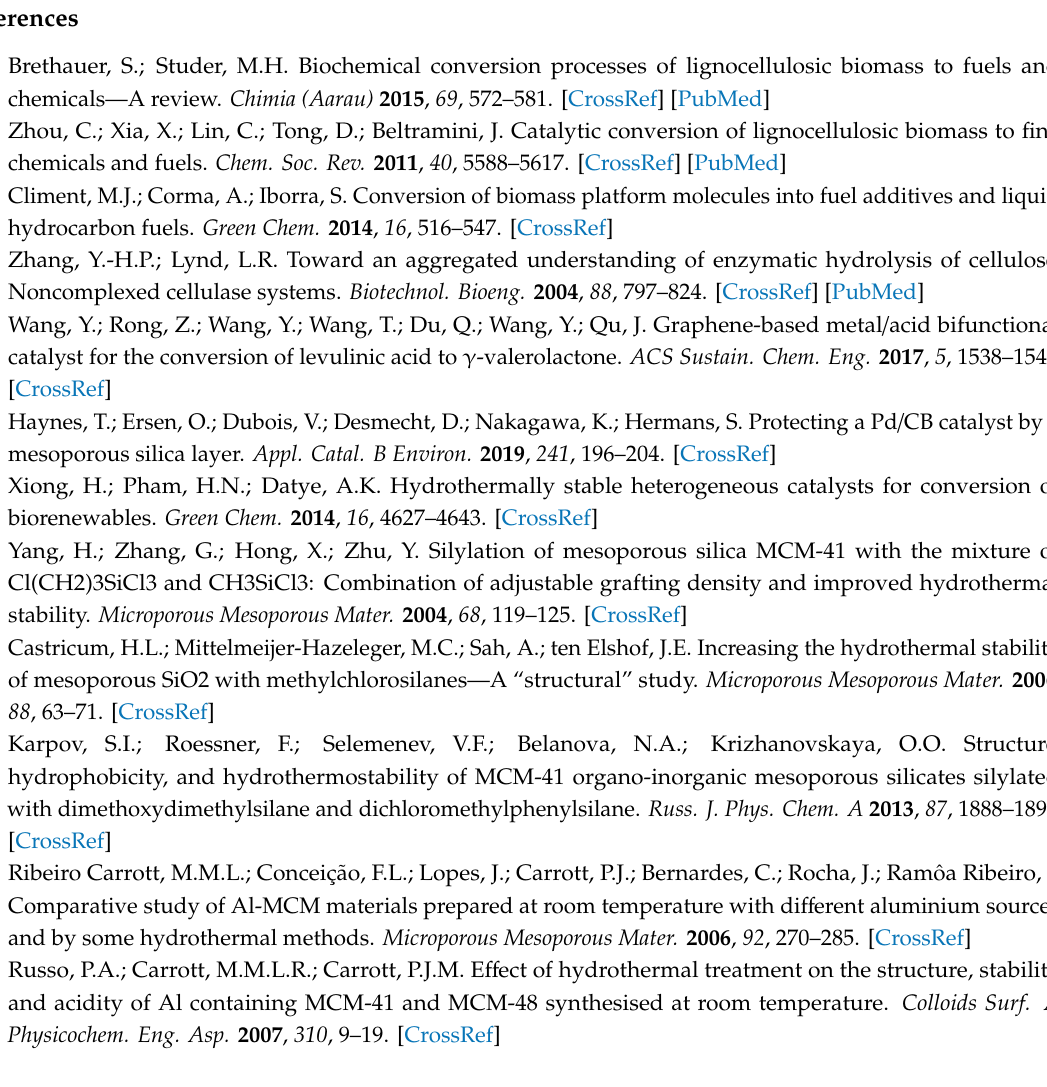
Figure S1: XPS Ru3p spectra for ( a ) Ru / CB, ( b ) Ru / CB@SiO 2 (C), and ( c ) Ru / CB@SiO 2 (P) catalysts. Figure S2: Pores size distribution obtained by DFT and BJH methods for ( a ) Ru / CB@SiO 2 (C) and ( b ) Ru / CB@SiO 2 (P) materials. Figure S3: SEM-EDX analyses of ( a ) Ru / CB, ( b ) Ru / CB@SiO 2 (C), and ( c ) Ru / CB@SiO 2 (P) catalysts. Figure S4: TEM images of ( a ) CB@SiO 2 (C) and ( b ) CB@SiO 2 (P) covered materials. Table S1: Elemental analysis by ICP of Ru / CB@SiO 2 (C) and Ru / CB@SiO 2 (P) catalysts (wt %). Table S2: XPS analyses (at %) of covered catalysts